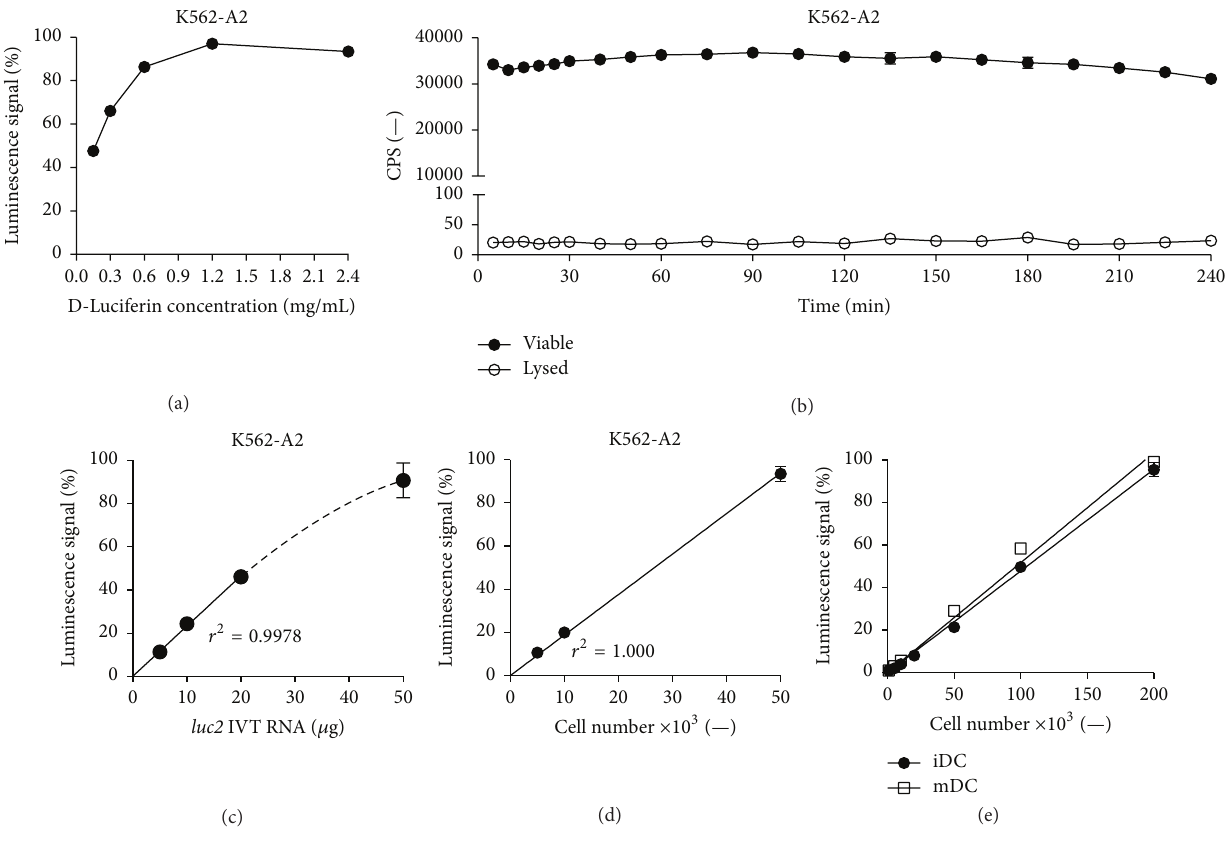
Figure 2: Optimization of the assay parameters enhances and prolongs luciferase signals whilst minimizing background reading and reveals a strict luminescence to cell number correlation. (a) Optimal D-luciferin substrate concentration. 1 × 10 6 K562-A2 cells were transfected with 20 𝜇 g luc2 IVT RNA. After 24 h, luminescence of 5 × 10 4 cells per well was measured following addition of D-luciferin in different concentrations. (b) Stable bioluminescence upon D-luciferin substrate addition and immediate abolition of signals following total cell lysis. 2.5 × 10 6 K562-A2 cells were transfected with 50 𝜇 g luc2 IVT RNA. 24 h after transfection, luminescence of 5 × 10 4 viable or 0.2% Triton X-100 treated cells was repeatedly measured after a single administration of 1.2mg/mL D-luciferin substrate. Graph represents mean ± SD luminescence ( 𝑛 = 3 ). (c) Luminescence is dependent on luc2 IVT RNA dose. 1 × 10 6 K562-A2 cells were transfected with different amounts of luc2 IVT RNA. 24h after transfection, luminescence of 5 × 10 4 cells per well was measured. (d) Luminescence is linearly dependent on the number of transfected K562-A2 cells. 1 × 10 6 K562-A2 cells were transfected with 50 𝜇 g luc2 IVT RNA. 24 h after transfection, 1.2mg/mL D-luciferin was added and luminescence of different amounts of cells was measured. (e) Luminescence is linearly dependent on the number of transfected primary cells. Human iDCs and mDCs were electroporated with 50 𝜇 g luc2 IVT RNA. 24 h after transfection, 1.2 mg/mL D- luciferin was added and luminescence of different amount of cells was measured. Cell number and signal intensity correlation ( 𝑝 < 0.0001 , 𝑟 2 = 0.9984 (iDC) and 0.9923 (mDC)). Graphs (a), (c), (d), and (e) represent mean ± SD luminescence ( 𝑛 = 3 ) relative to the highest luminescence signal obtained within each